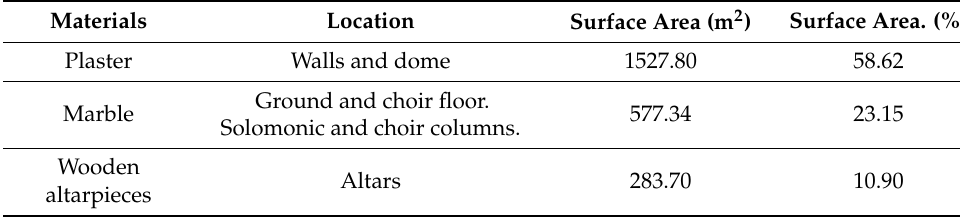
Table 3. Materials, location, surface area, and